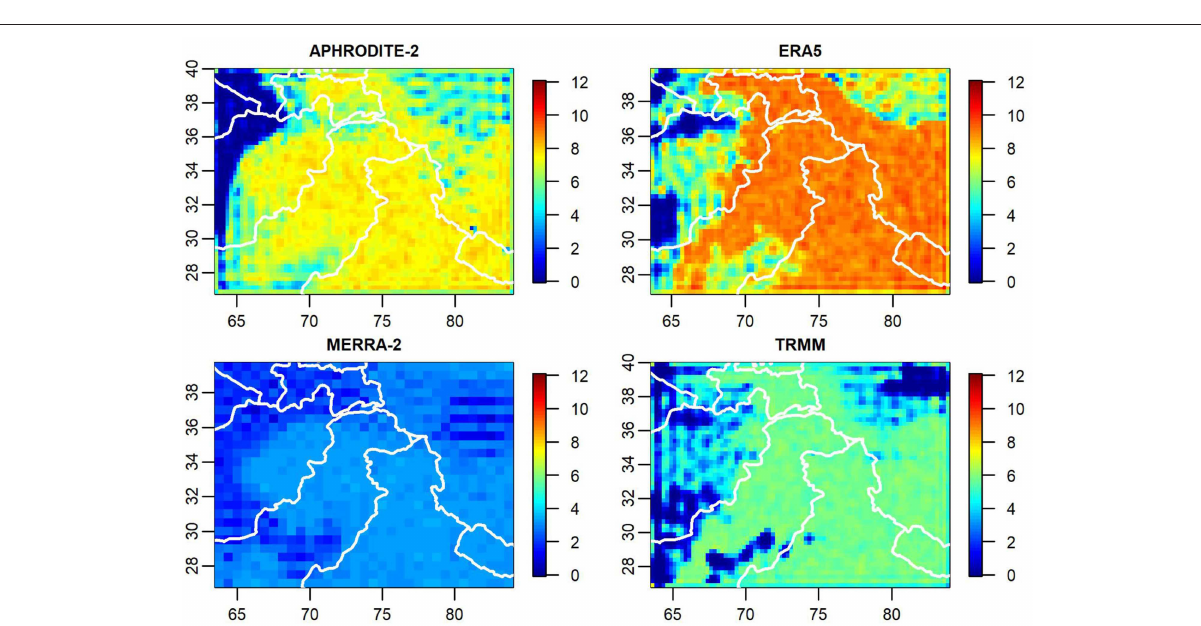
FIGURE 6 | Uncertainty associated with noiseless data approximation for August 2000 (in